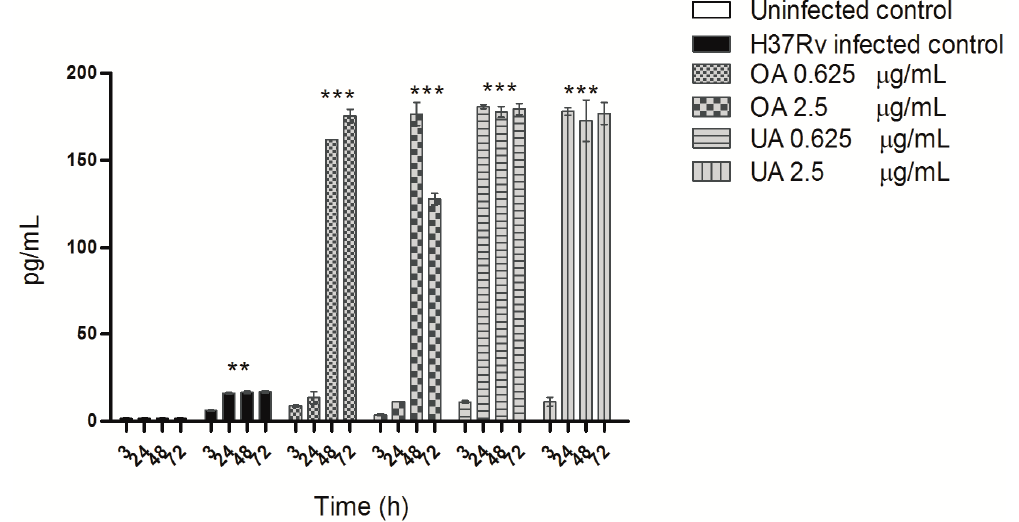
Figure 6. TNF- α production by macrophages infected with M. tuberculosis H37Rv and treated with OA and UA. Macrophages infected with strain H37Rv and treated with different concentrations of OA and UA for 3, 24, 48 and 72 h post-infection. TNF- α levels in cell supernatants from uninfected, infected and treated macrophages were quantified with a commercial ELISA kit. The data are presented as means ± SD from three different experiments. Statistically significant differences indicated are when infected and treated cells values (OA, UA), were compared with infected cells (H37Rv infected control) (*** p < 0.001), or when non-infected cells (Uninfected control) where compared with infected cells (H37Rv infected control) (** p <